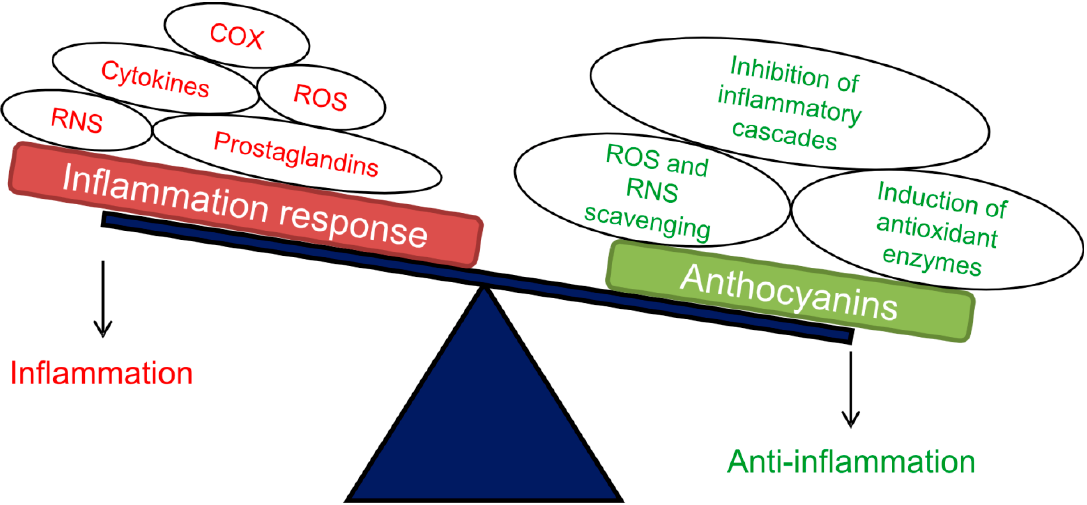
Figure 2. Schematic representation of the main positive effects exerted by anthocyanins as anti-inflammatory compounds. Abbreviations: ROS, reactive oxygen species; RNS, reactive nitrogen species; COX, cyclooxygenase enzyme. Adapted from [85].